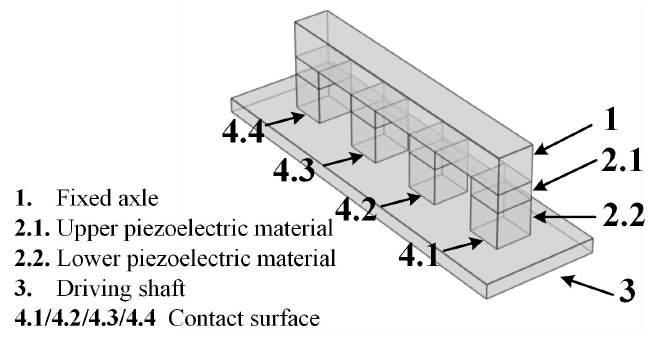
Figure 4. The simulation model of the inchworm motor.